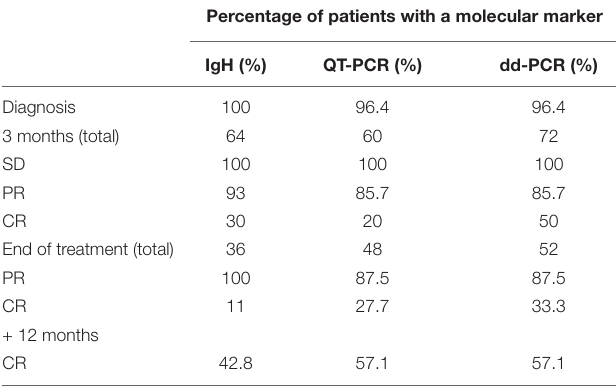
TABLE 3 | Comparison among qualitative PCR for IgH rearrangement, QT-PCR for B-RAF V600E mutation, and dd-PCR. Percentage of patients with a molecular marker